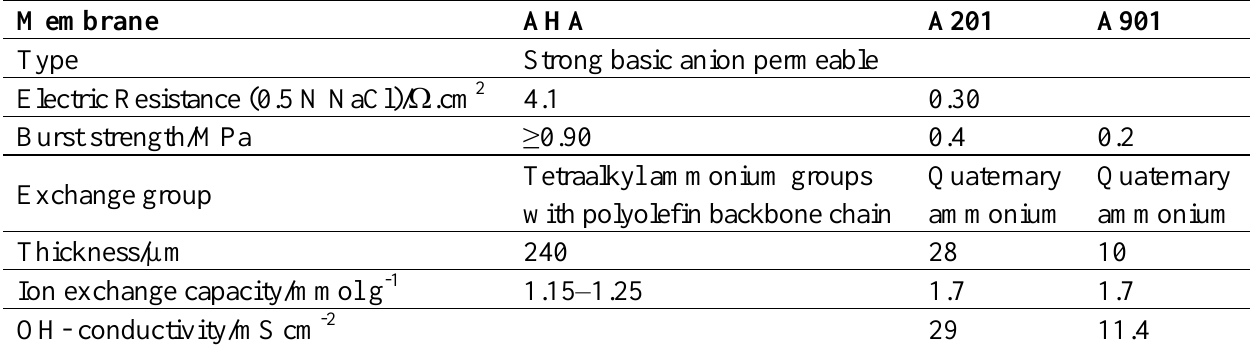
Table 4. Basic properties of Tokuyama membranes